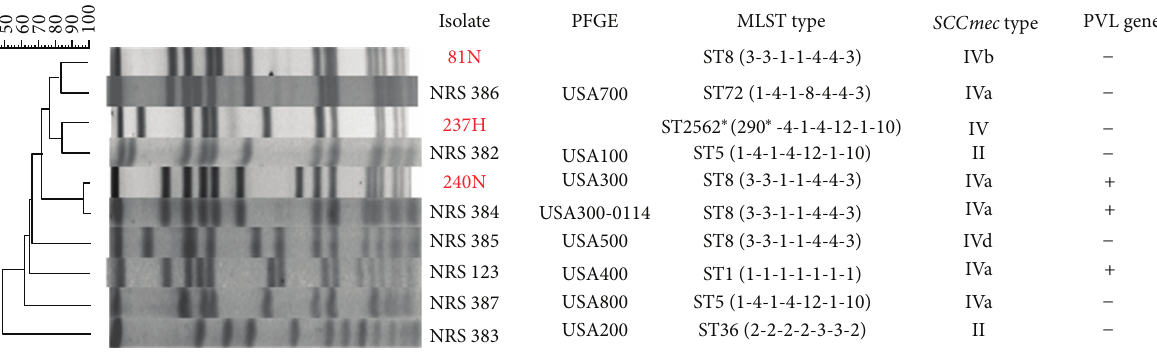
F 1: Molecular and genotypic traits of methicillin-resistant Staphylococcus aureus (MRSA) isolates. PFGE, pulsed �eld gel electrophore- sis; MLST, multilocus sequence typing; SCC mec , staphylococcal cassette chromosome mec ; PVL, Panton-Valentine leukocidin (+,